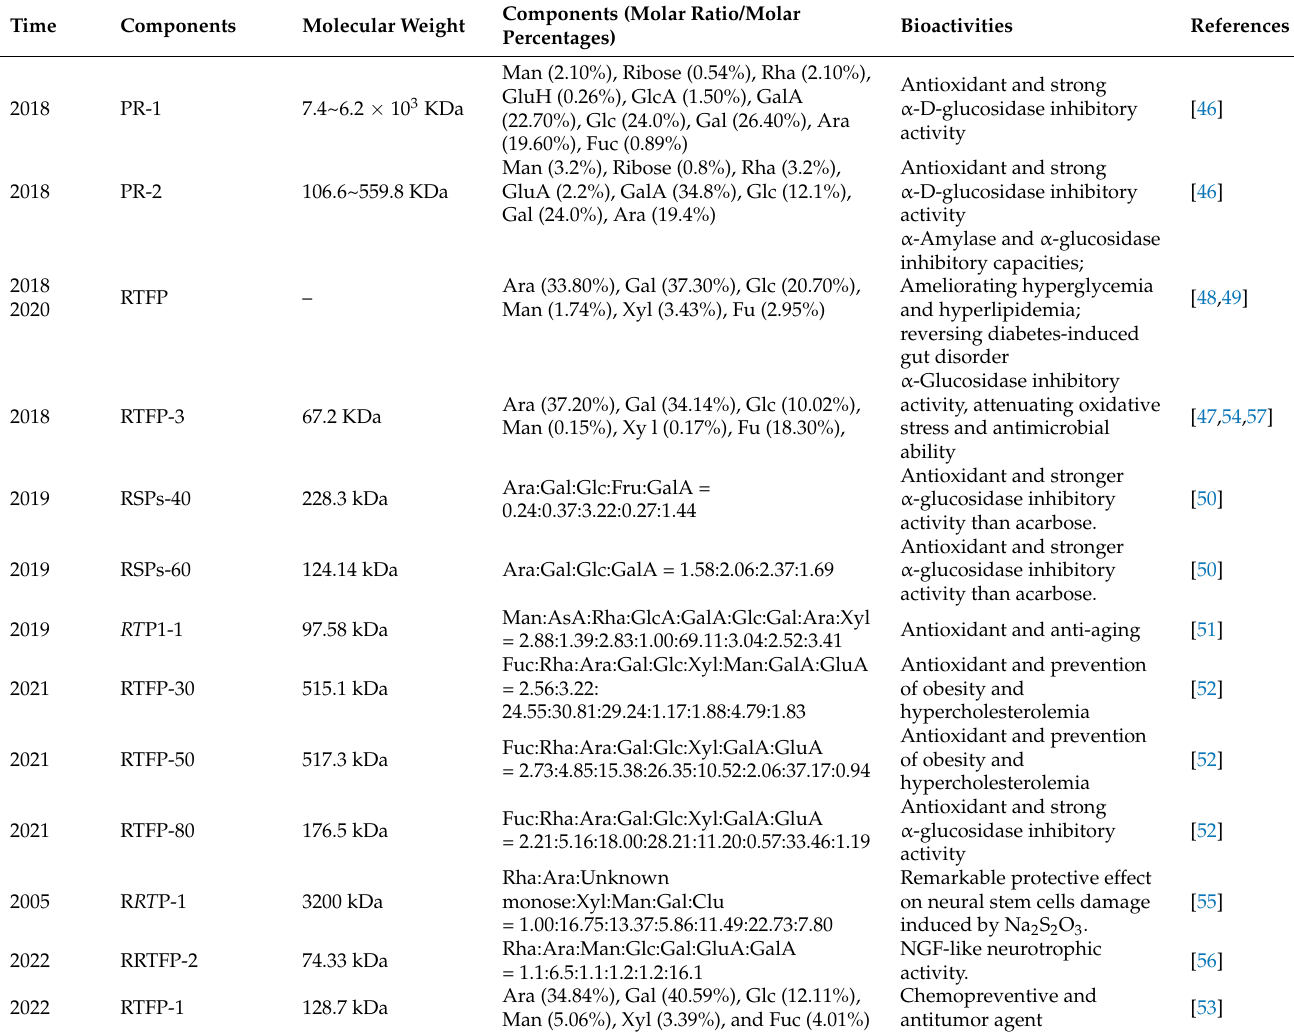
Table 3. Components and bioactivities of R. roxburghii polysaccharide